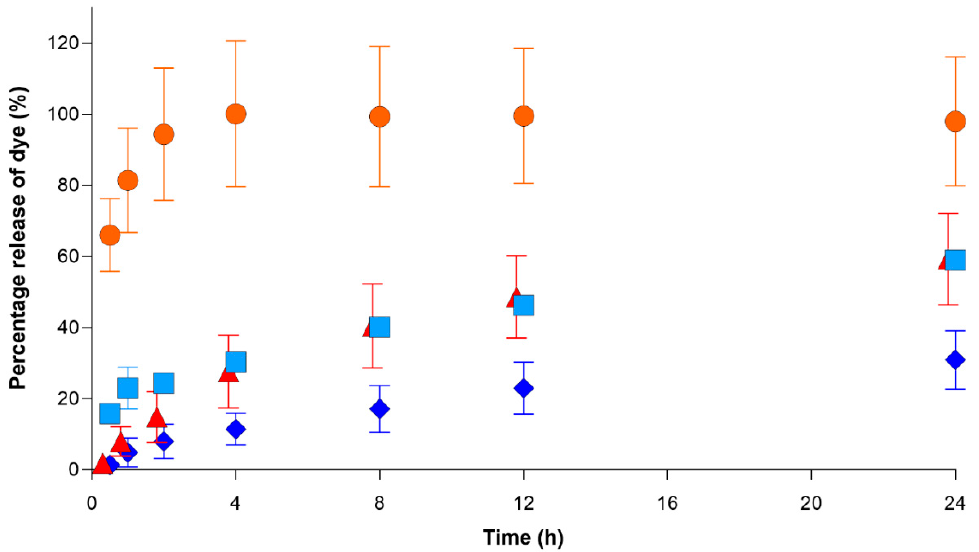
Figure 3. Release of red dye (mg) over 24 h from ( ) etafilcon A in a vial, ( ) senofilcon A in a vial, ( ▲ ) etafilcon A on the eye model, and ( ) senofilcon A on the eye model (n = 3). The total amount of dye absorbed was 47.8 ± 2.7 mg for etafilcon A and 22.4 ± 2.0 mg for senofilcon A. The percentage release of the dye released from the lenses is shown in Figure 4. In both the vial and the eye model, the total percentage of drugs released for etafilcon A was significantly higher than that for senofilcon A ( p < 0.05). In the vial, there was an initial burst release of the dye for etafilcon A, which reached 100% of the total release within the first 4 h. In contrast, the release was more gradual for senofilcon A over